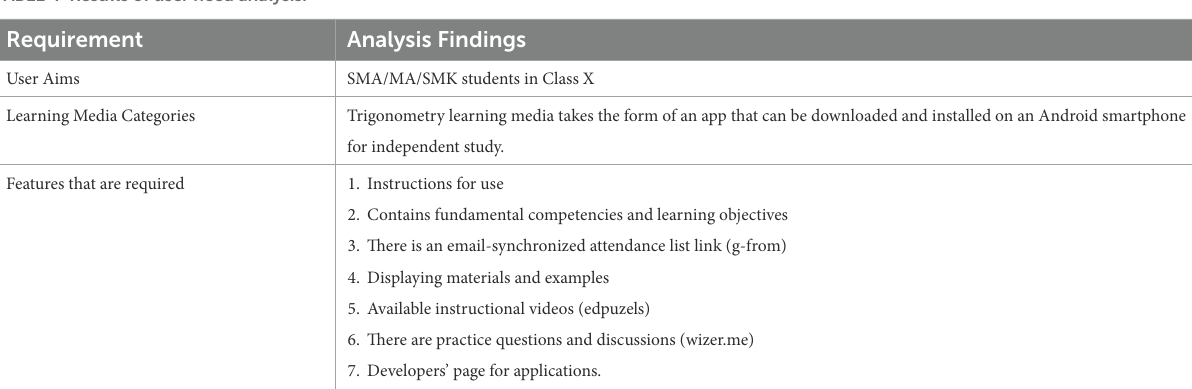
TABLE 4 Results of user need analysis.